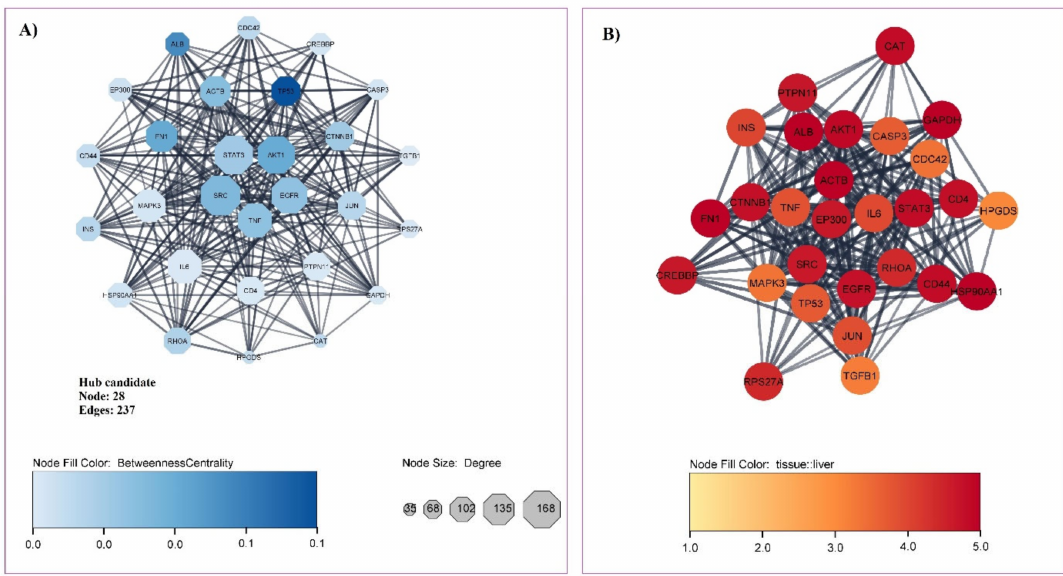
Figure 3. ( A ) Hub protein/gene candidate interaction network constructed by filtering pro- teins/genes by high-level centralities using Cytoscape software. Twenty-eight candidate hubs with 237 edges were identified. The Degree is depicted with the size of nodes, and Betweenness is depicted with the intensity of the node color. ( B ) The amount of presentation of proteins/genes related to liver cirrhosis liver tissue. The intensity of the color indicates the amount of presentation in the